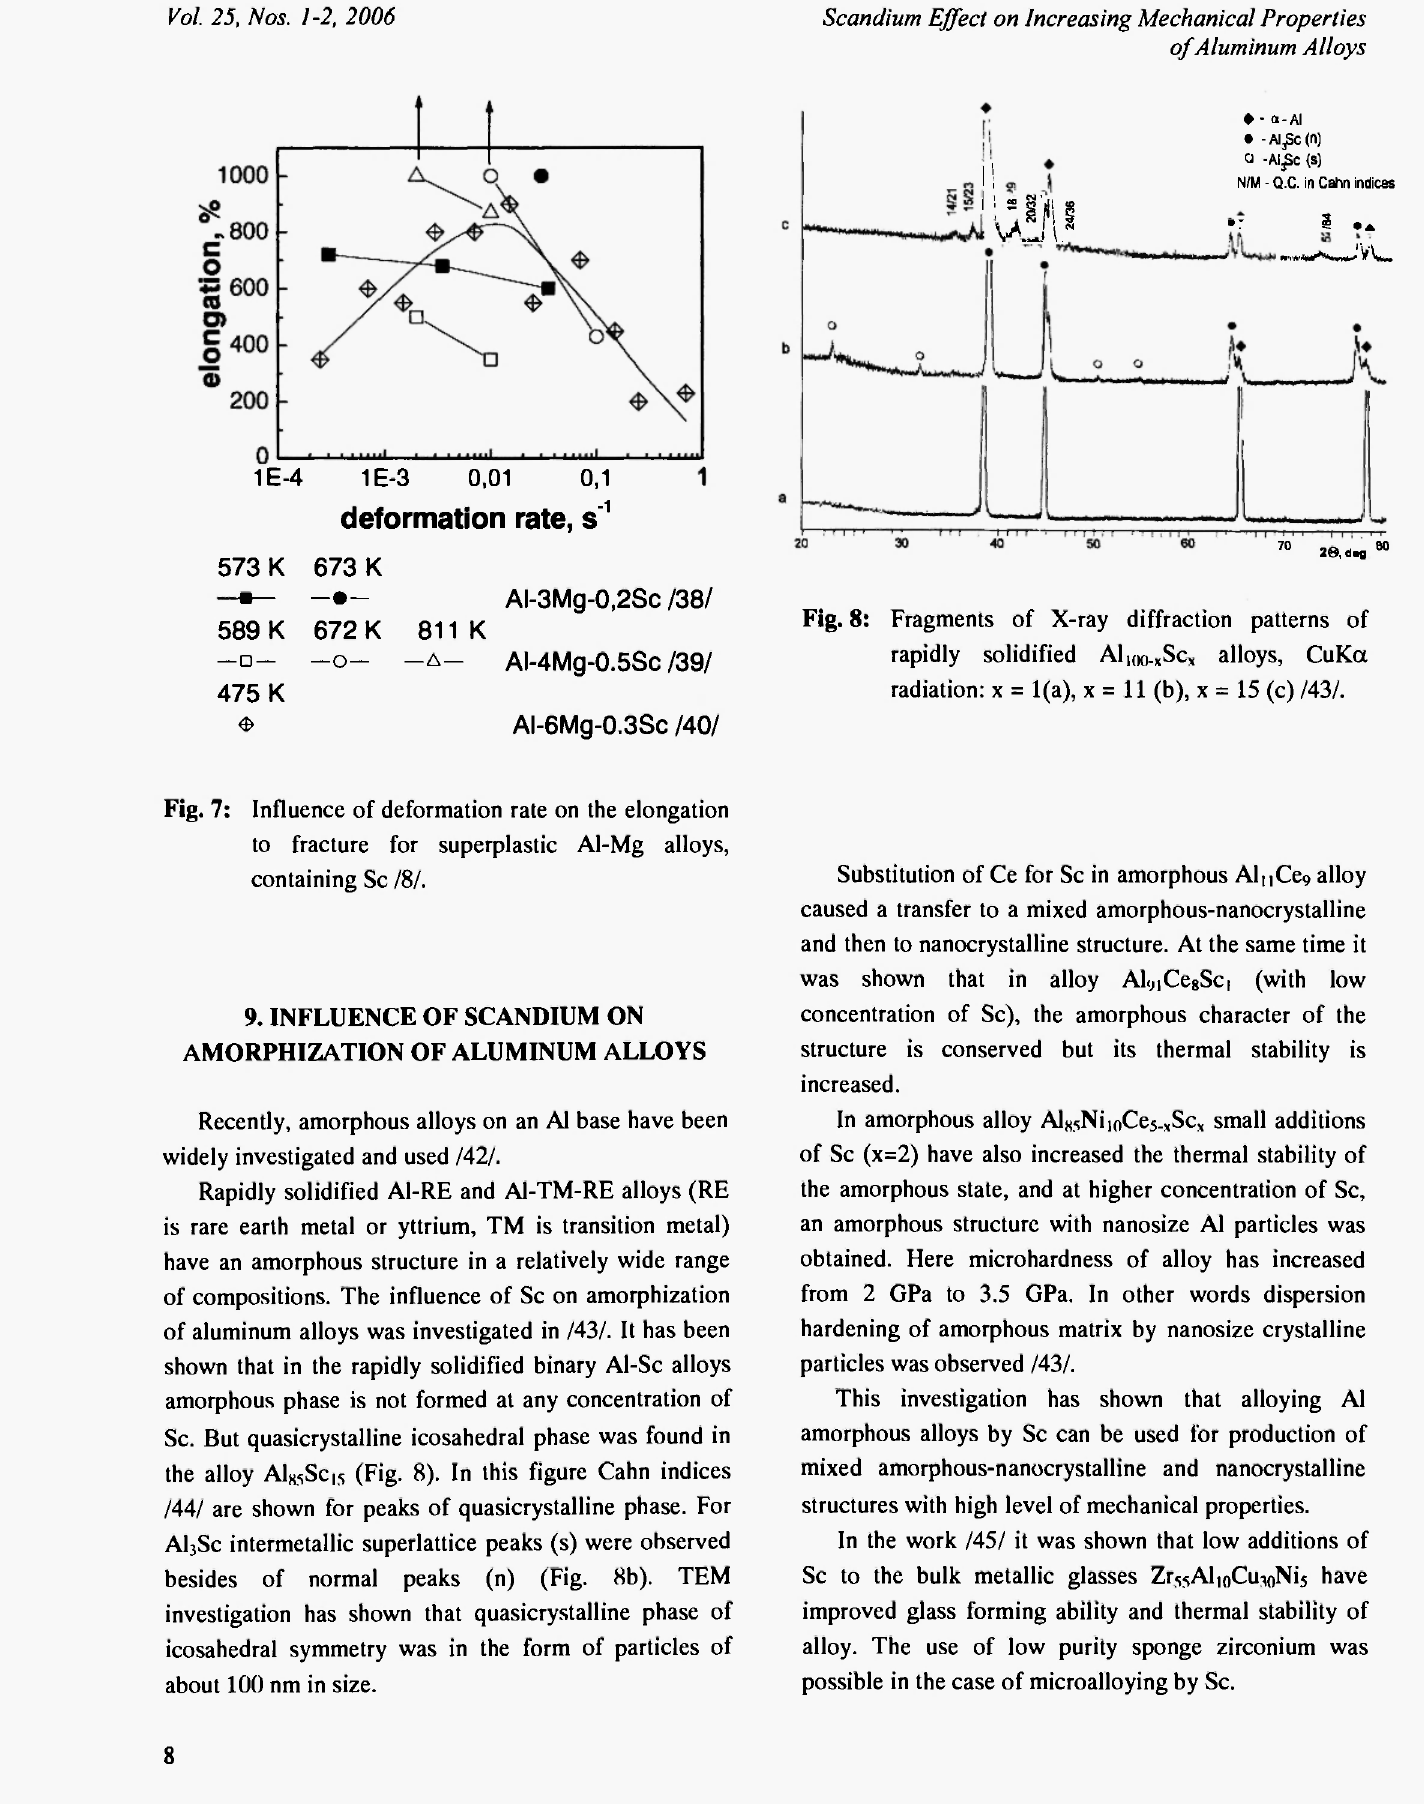
Fig. 8: Fragments of X-ray diffraction patterns of rapidly solidified Al 1(K) . x Sc x alloys, CuKa